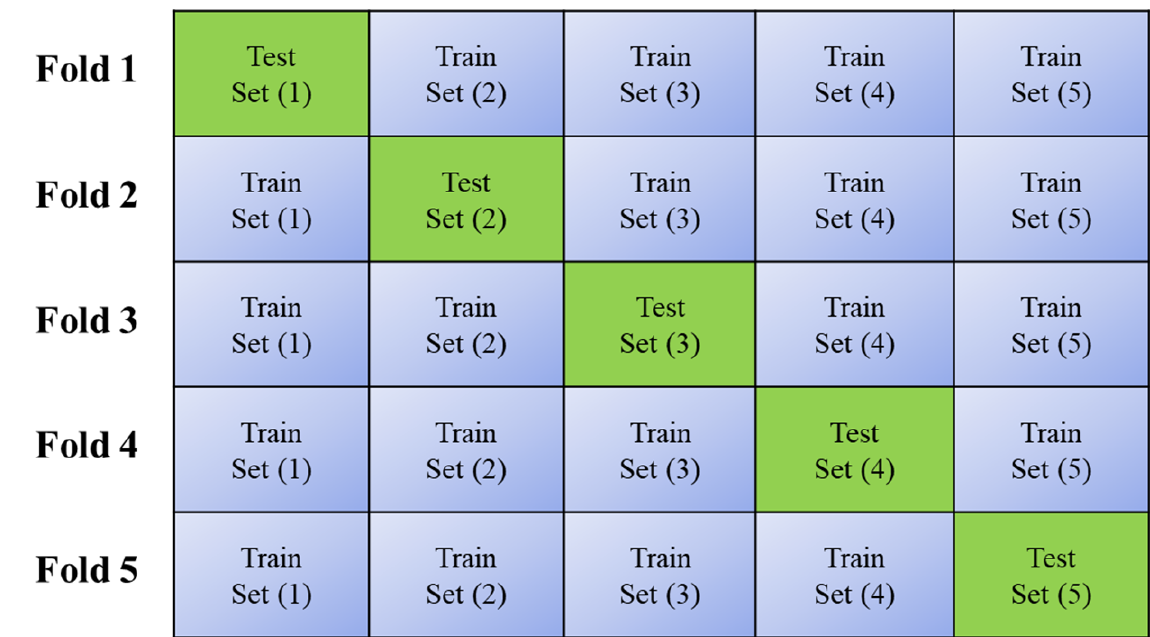
Figure A1. An idea of five-fold cross-validation.